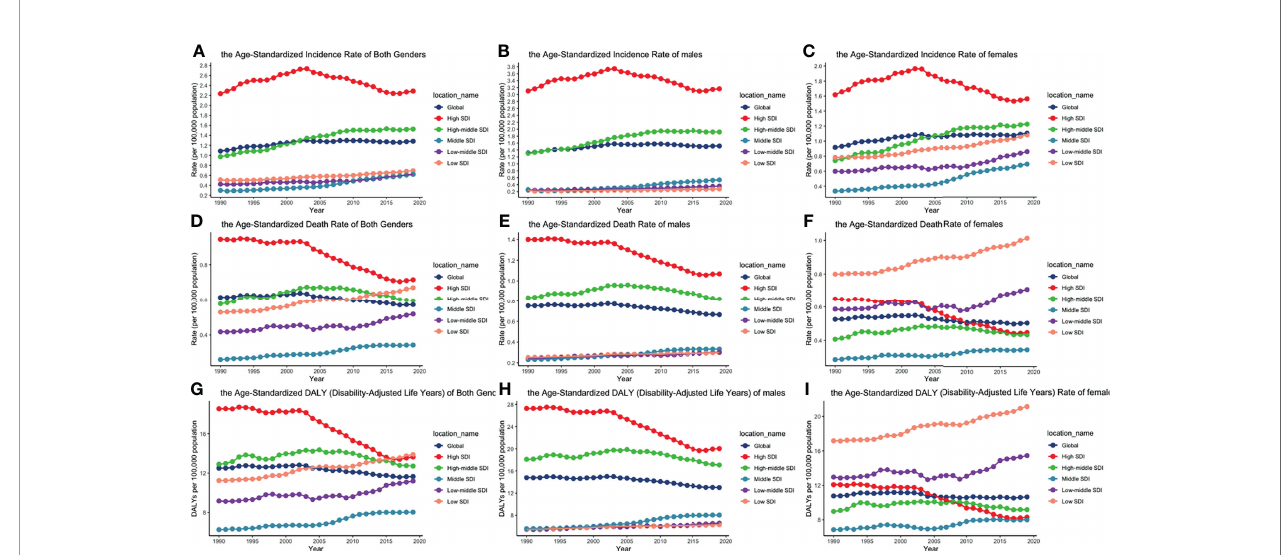
FIGURE 2 | ASIRs, ASDRs, and age-standardized DALY rates of different SDI quintiles from 1990 to 2019 by gender: (A) ASIRs of both genders; (B) ASIRs of males; (C) ASIRS of females; (D) ASDRs of both genders; (E) ASDRs of males; (F) ASDRs of females; (G) age-standardized DALY rates of both genders; (H) age- standardized DALY rates of males; (I) age-standardized DALY rates of females. (ASIR, age-standardized incidence rate; ASDR, age-standardized death rate; DALY, disability-adjusted life year; SDI, socio-demographic index).